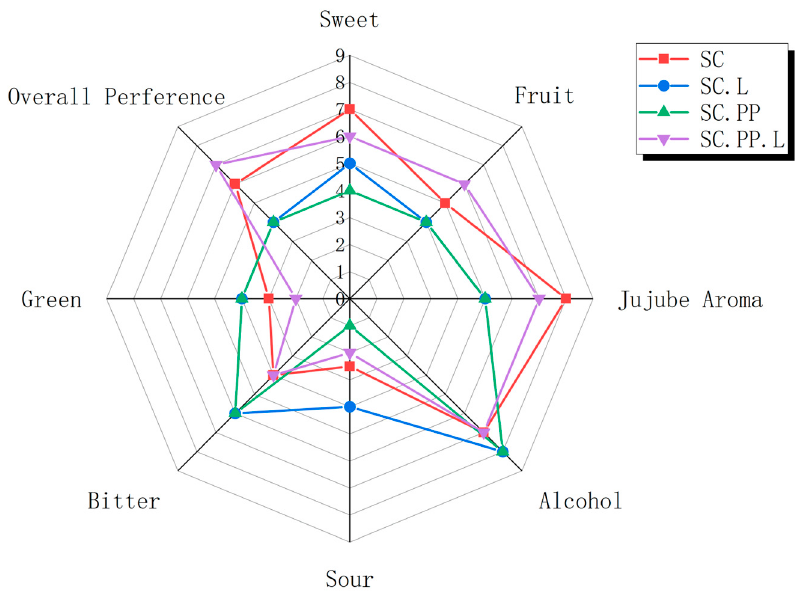
Figure 5. Sensory evaluation radar chart of different groups of jujube liquor. ( S. cerevisiae -‘SC’, S. cerevisiae and Lactobacillus -‘SC.L’, S. cerevisiae , and P. pastoris -‘SC.PP’, S. cerevisiae , P. pastoris , and Lactobacillus -‘SC.PP. L’).